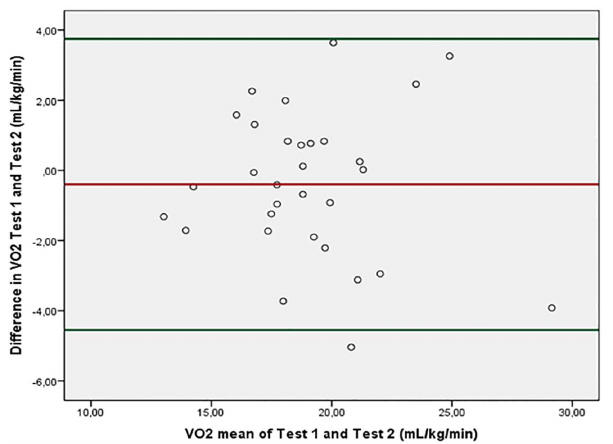
Fig 3. Bland-Altman plot of within subject change in VO 2 between Test 1 and Test 2 (mL/kg/min). Red horizontal line represents the mean difference betweentests. Green horizontal lines are reference lines representing 5% and 95% confidenceintervals( ± 1.96